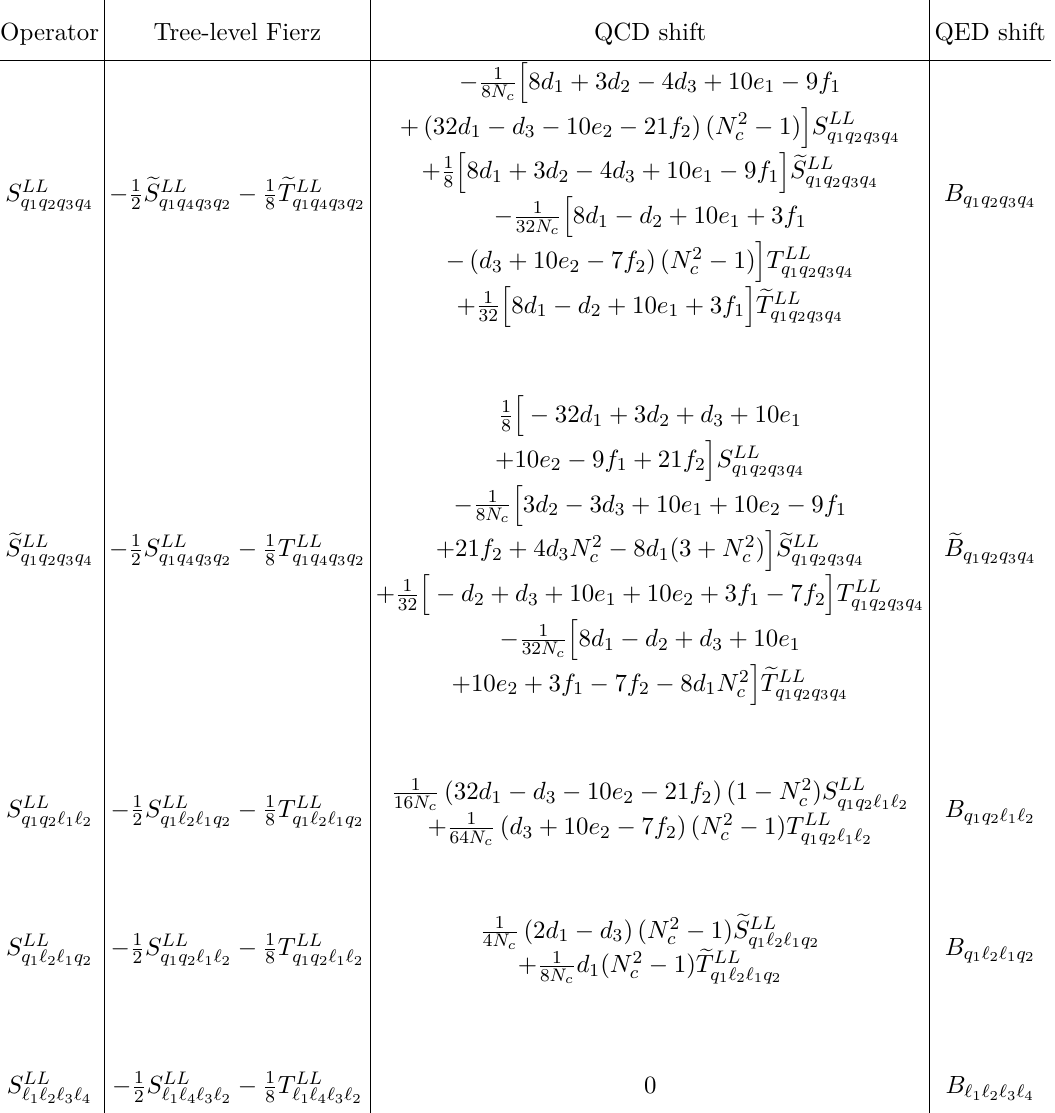
Table 9. Fierz transformations for scalar P L ⊗ P L operators together with their one-loop QCD and QED shifts in the generalised BMU